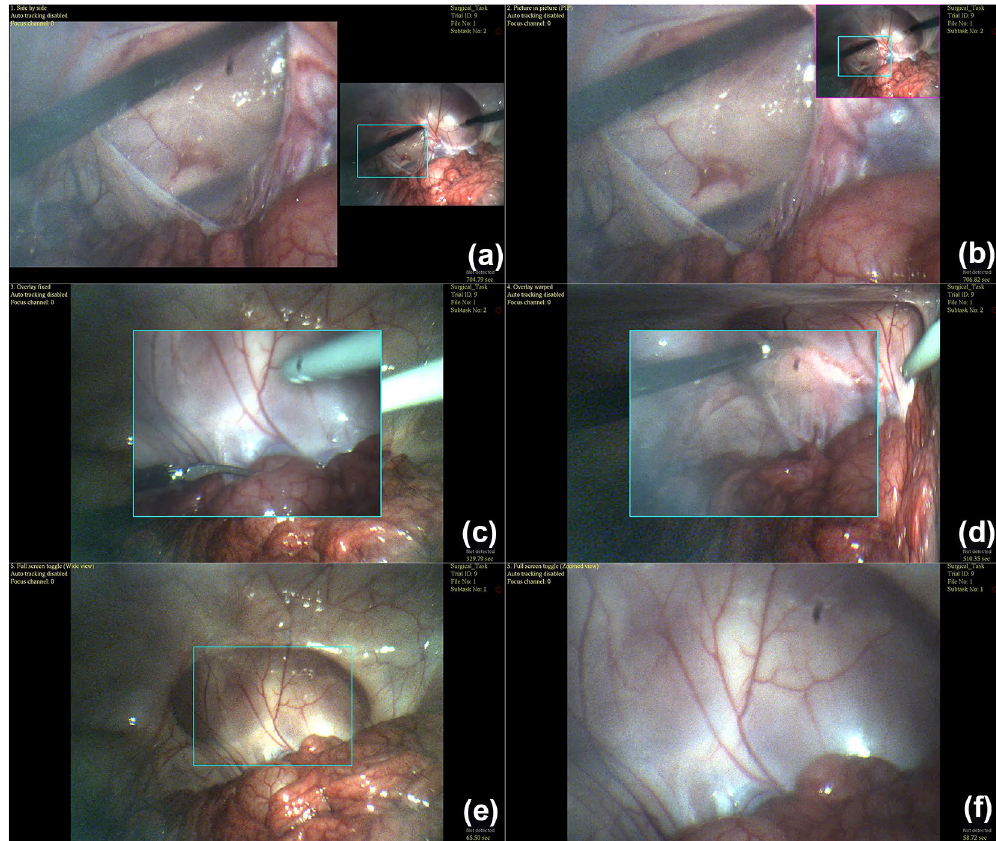
Figure 11. Images captured using different viewing modes during in-vivo testing of the MRFL. The view modes offered during in-vivo testing were: ( a ) O + D; ( b ) PIP; ( c ) FF + OC; ( d ) FF + WC; and ( e,f ) FST. These view modes are further demonstrated in Supplementary Video S1.